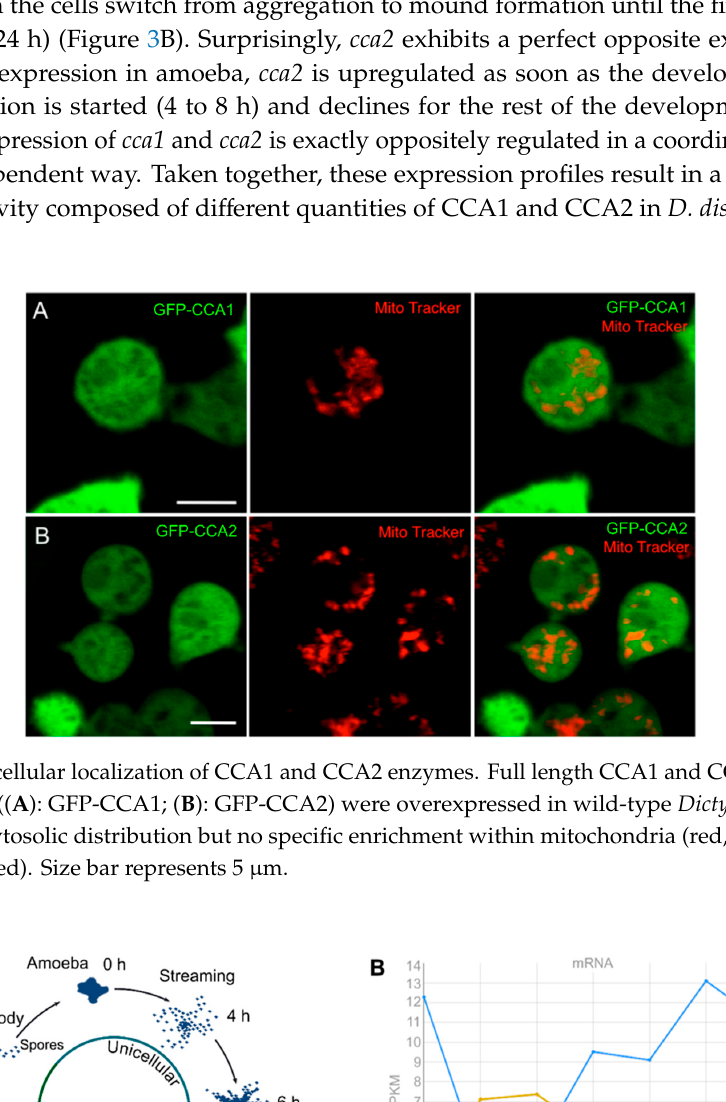
Figure 3. CCA1 and CCA2 are oppositely regulated during D. discoideum development. ( A ) Schematic presentation of the D. discoideum life cycle. Upon starvation, cells release cAMP as an external signal and move towards an aggregation center, where they form a multicellular organism. Eventually, this organism forms a fruiting body consisting of di ff erentiated spore and stalk cells. Under improved growth conditions, the released spores grow out again into vegetative cells. ( B ) mRNA profiles of cca1 (DDB_G0293504) and cca2 (DDB_G0271378) genes according to dictyExpress. At time point 0, mRNA levels of cca 1 are high and decrease during the first hours of development, increase again after 8 h and reach the initial level during the final stages of development. In contrast, mRNA levels of cca2 are close to zero at time point 0 and increase to a maximum after 4 to 8 h. Then, the levels decrease continuously until 24 h. Taken together, the diagram shows a diametrically contrary transcription of cca1 and cca2 genes, indicating specific functions during the life